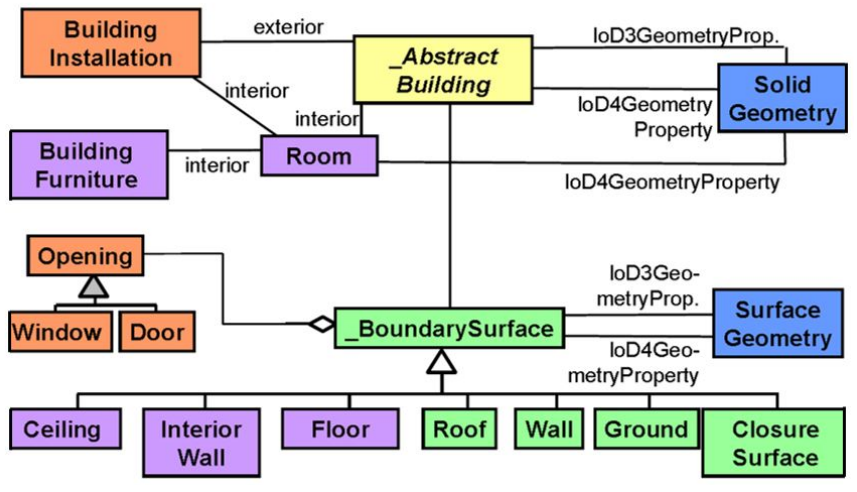
Figure 9. CityGML building model in LoDs 0 to 4 [35].